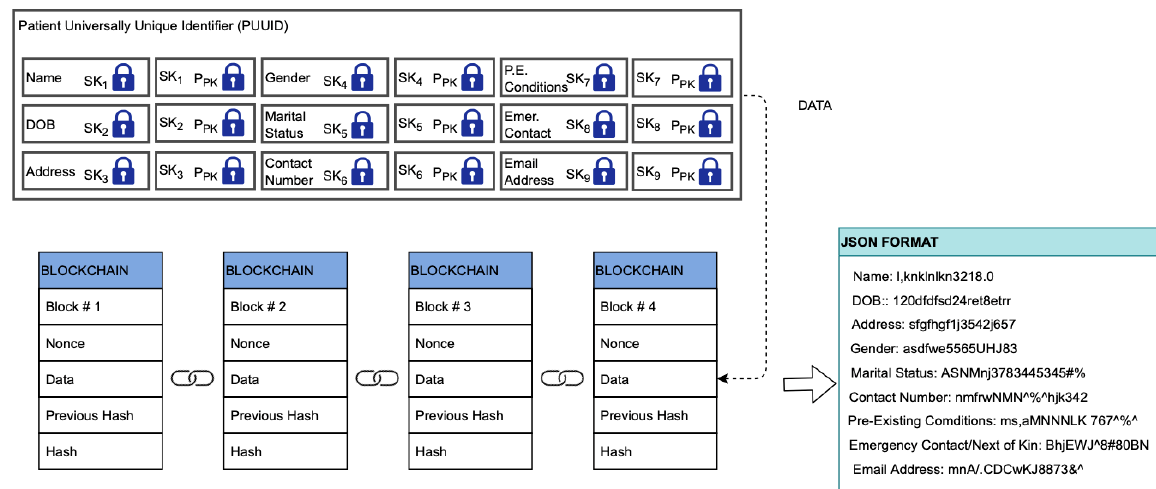
Figure 11. Patient information data structure and PIB commit.